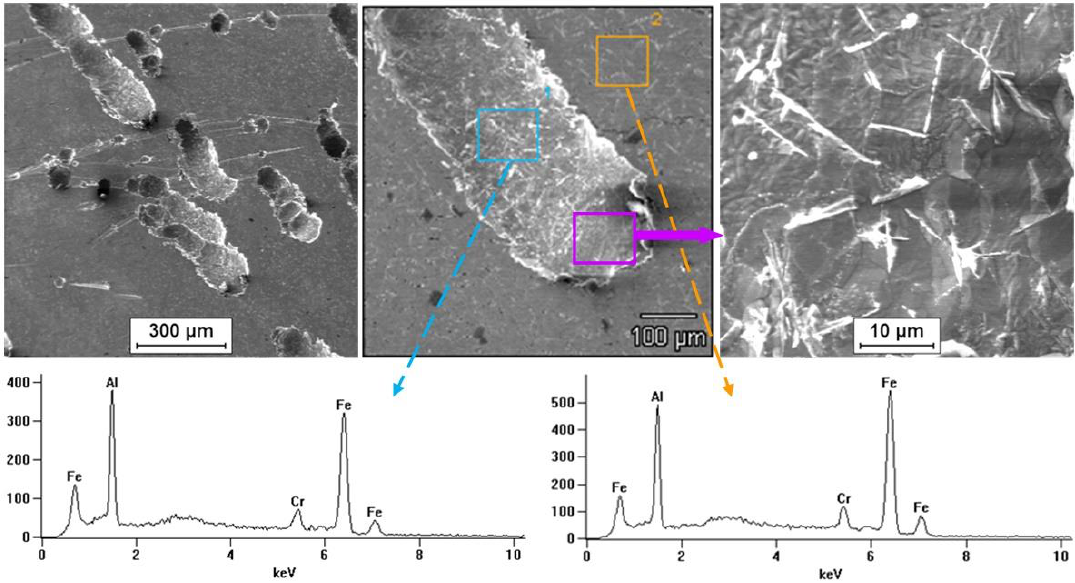
Figure 13. Surface of alloy Fe40Al5Cr0.2TiB after hot rolling and corrosion test.